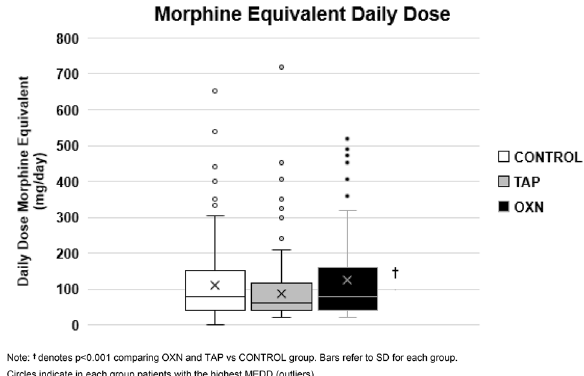
Figure 1. Daily morphine equivalent dose (MEDD) (mean ± SD) depending on control and tapentadol (TAP) and oxycodone/naloxone (OXN) cases